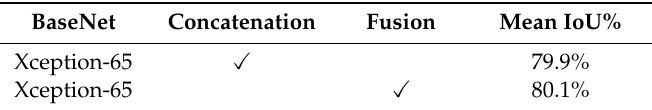
Table 3. Performance on Cityscapes val. set using concatenation operation versus fusion operation for combining features.